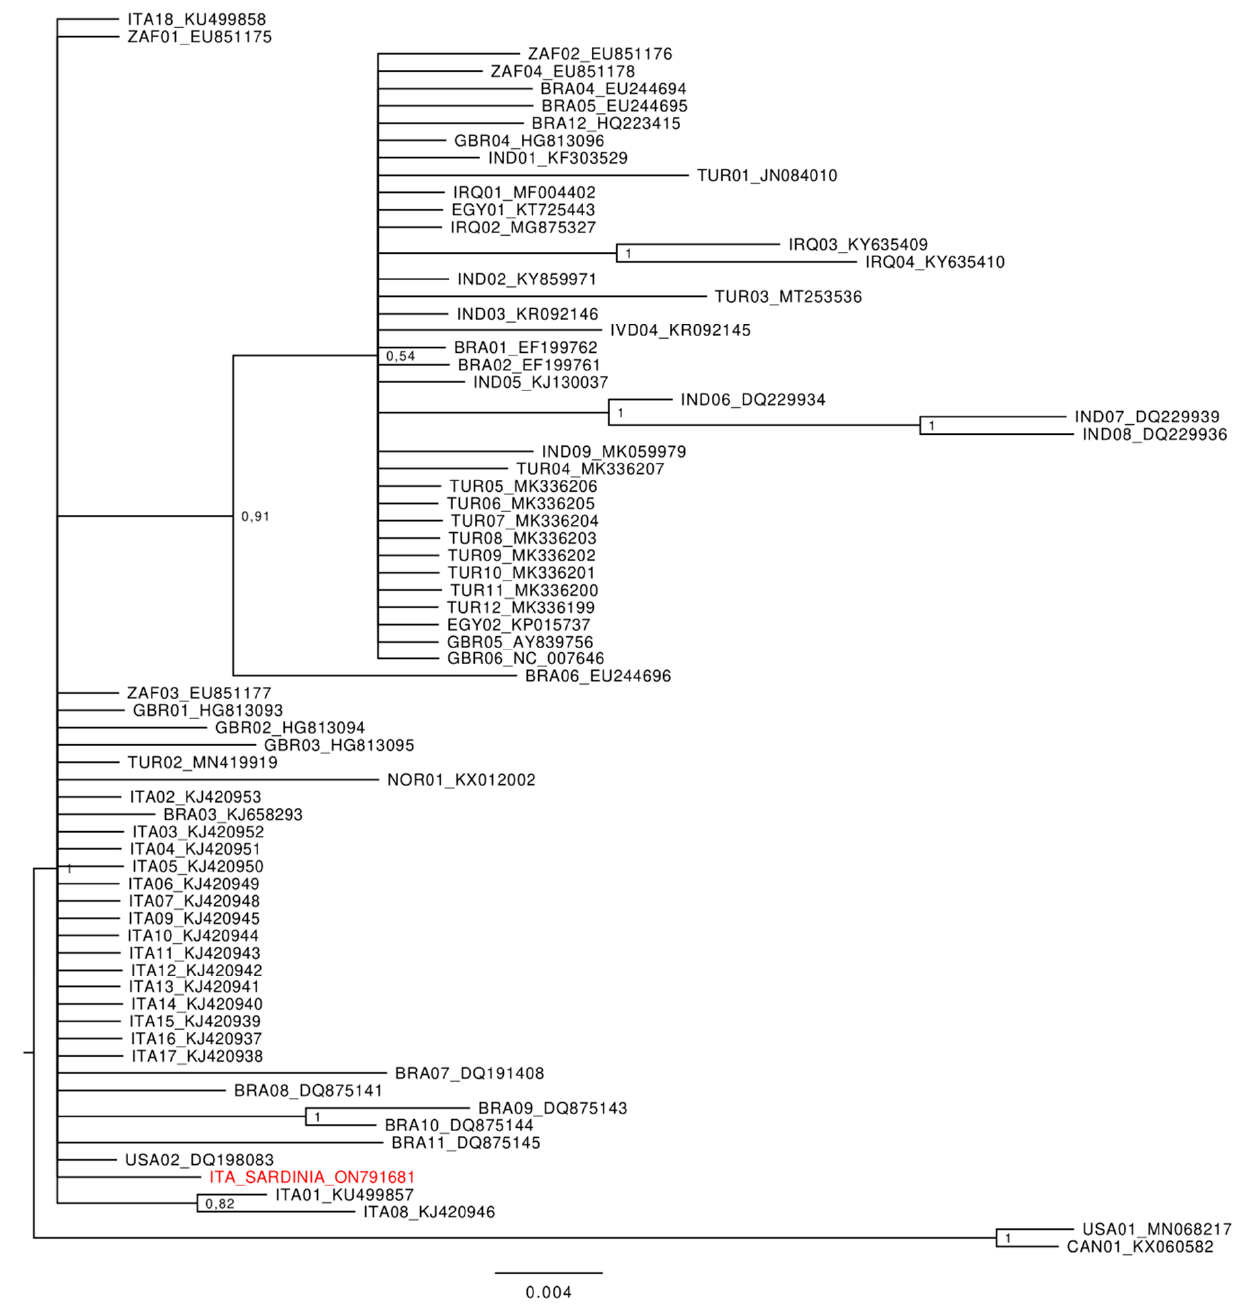
Figure 3. Bayesian phylogenetic tree based on 131bp-long sequences of the ORF75 gene isolated for OvHV-2 in cases of malignant catarrhal fever worldwide. Values of node supports are expressed as Posterior Probabilities. The ORF75 gene sequence isolated in Sardinia is indicated in red font. The codes of sequences within the tree report the conventional code of the country where samples were collected (the first three letters) and the corresponding GenBank accession number.